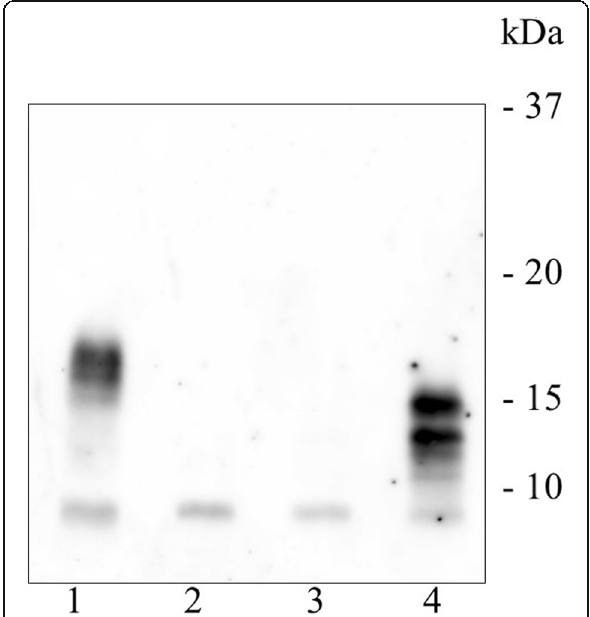
Fig. 2 Western blot analysis of serum. Compared to healthy control IGF2 (lane 3) and a previous IGF2-producing tumor (lane 4), preoperative serum (lane 1) of the patient contained high- molecular-weight IGF2, designated “ big IGF2. ” Postoperative serum